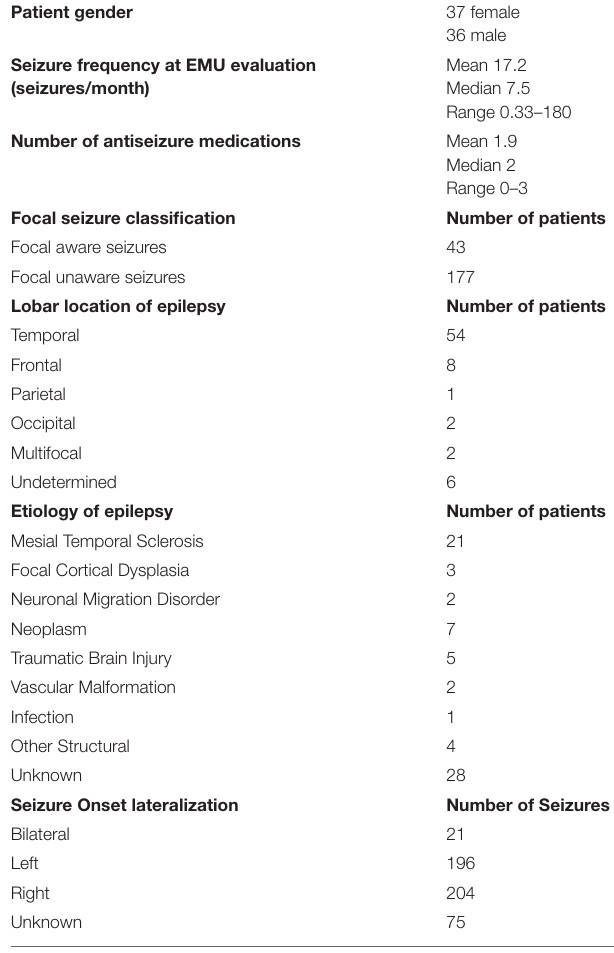
TABLE 1 | Clinical characteristics.